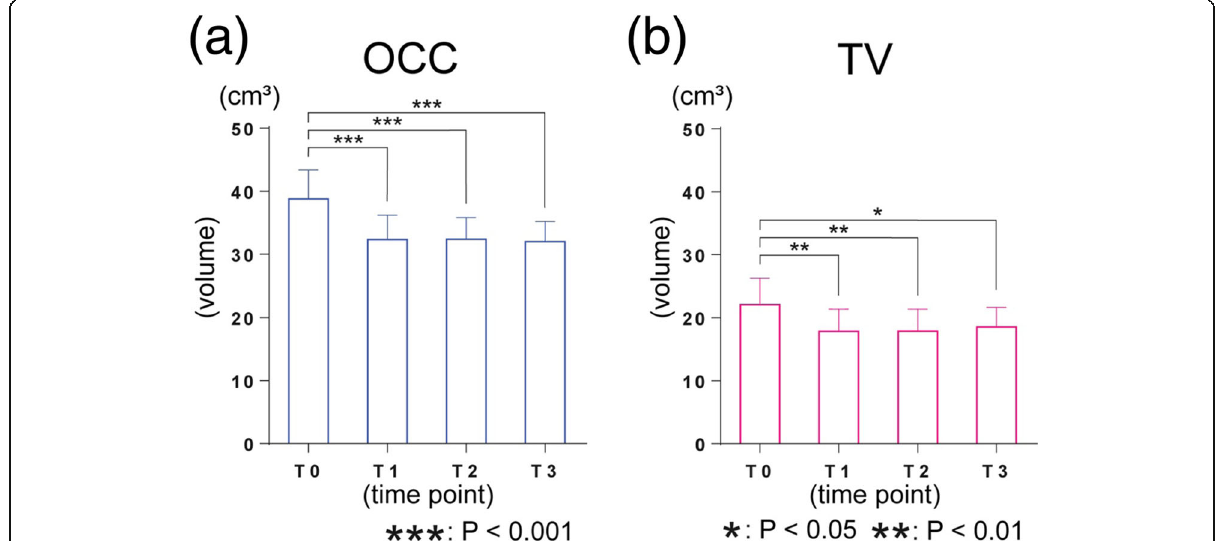
Fig. 5 Value of OCC and TV at each time point. a The OCC values at T1, T2, and T3 were significantly smaller than T0 (T1, T2, T3: P < 0.001). b The TV values at T1, T2, and T3 were significantly smaller than T0 (T1, T2: P < 0.01, T3: P <